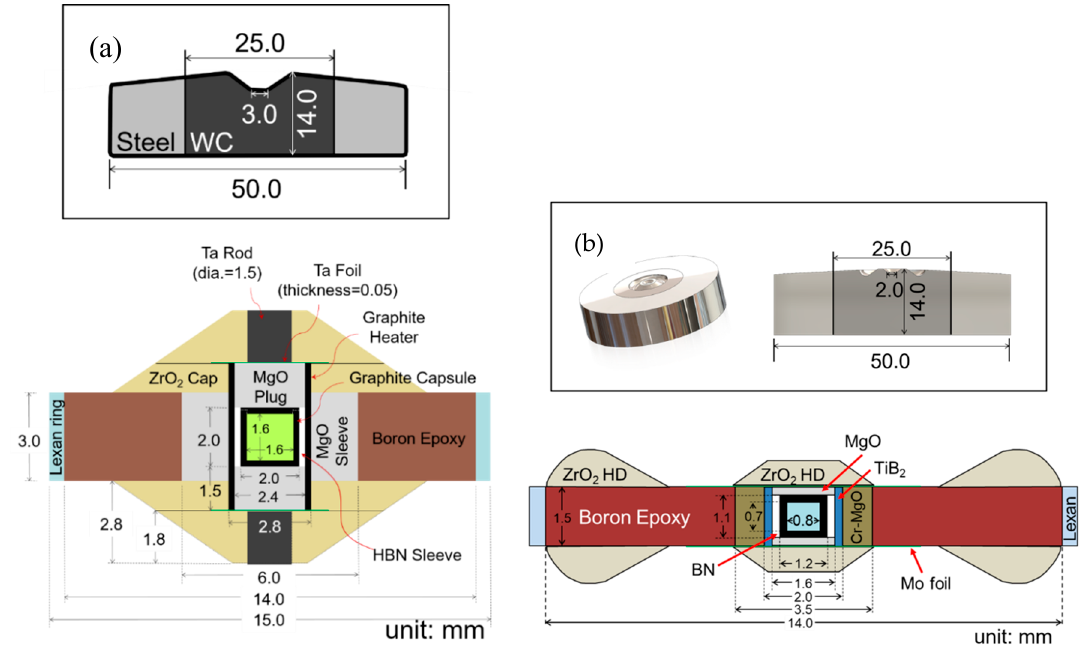
Figure 5. ( a ): The standard 3 mm Paris-Edinburgh cell assembly (bottom) that can reach 7 GPa and 2300 K. The 1.6 mm diameter sample size is the largest that we can accommodate in our setup. The 3 mm Paris-Edinburgh anvil (top) is custom-made by Fujilloy. The center part of the anvil is tungsten carbide with a steel ring surrounding it for lateral support. ( b ) For pressures up to 12 GPa, a 2 mm cell assembly (a TiB 2 heater and a graphite sample capsule) is utilized (bottom). From both the full image and the cross section of the 2 mm cupped-toroidal Drickamer anvil (top), one can clearly see the toroidal-cut groove that helps to prevent the pressure medium from flowing outward under compression. Similar to the 3 mm standard anvils, the cupped-toroidal Dricakmer anvil also consists of a tungsten carbide center part and an outer supporting steel